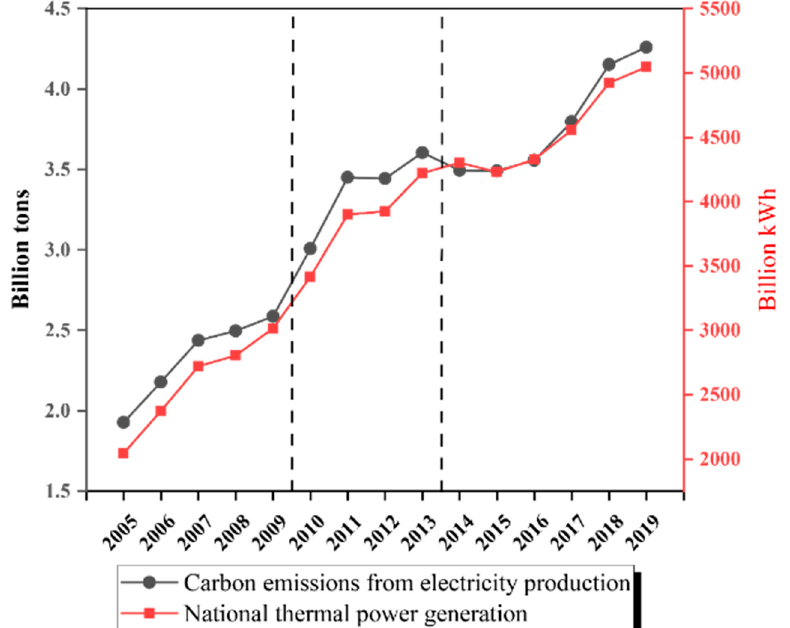
Figure 4. The total carbon emissions from the power sector over the period between 2005 and 2019.